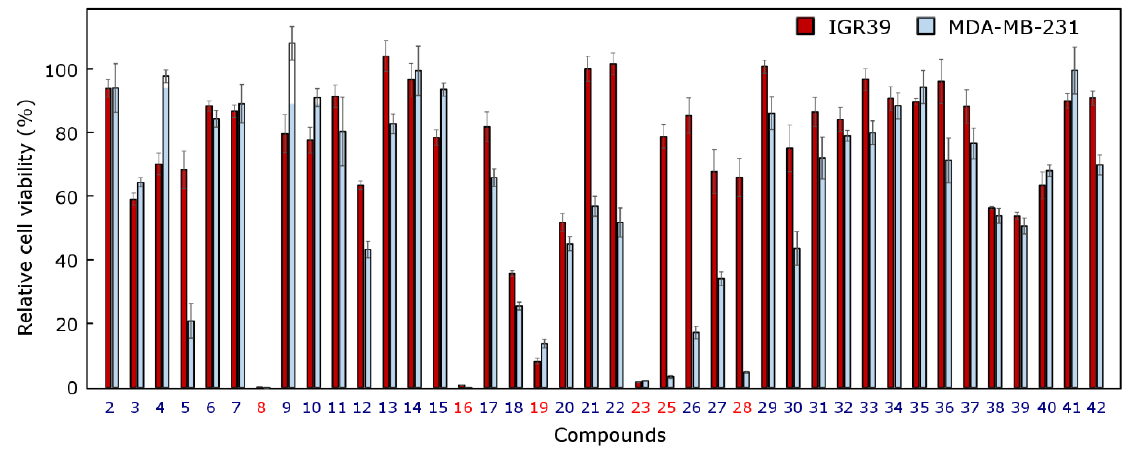
Figure 2. Effect of tested compounds on cancer cell viability at 100 µM concentration after 72 h of incubation, n = 3. Experiments were repeated three times, calculating the mean and standard deviation. The number of the most active compounds selected for further experiments are shown in red.